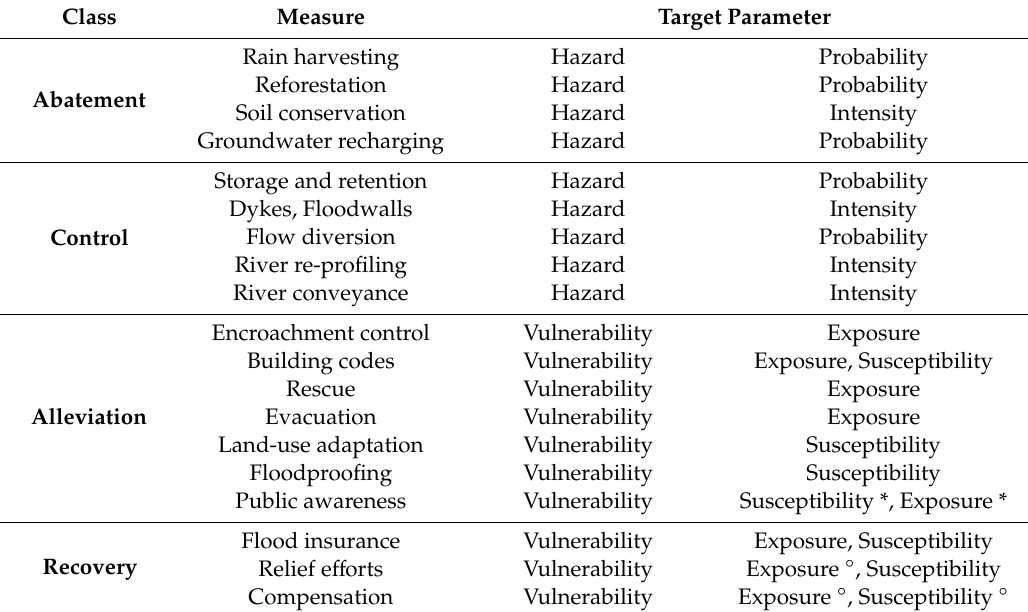
Table 1. Flood management measures and target risk